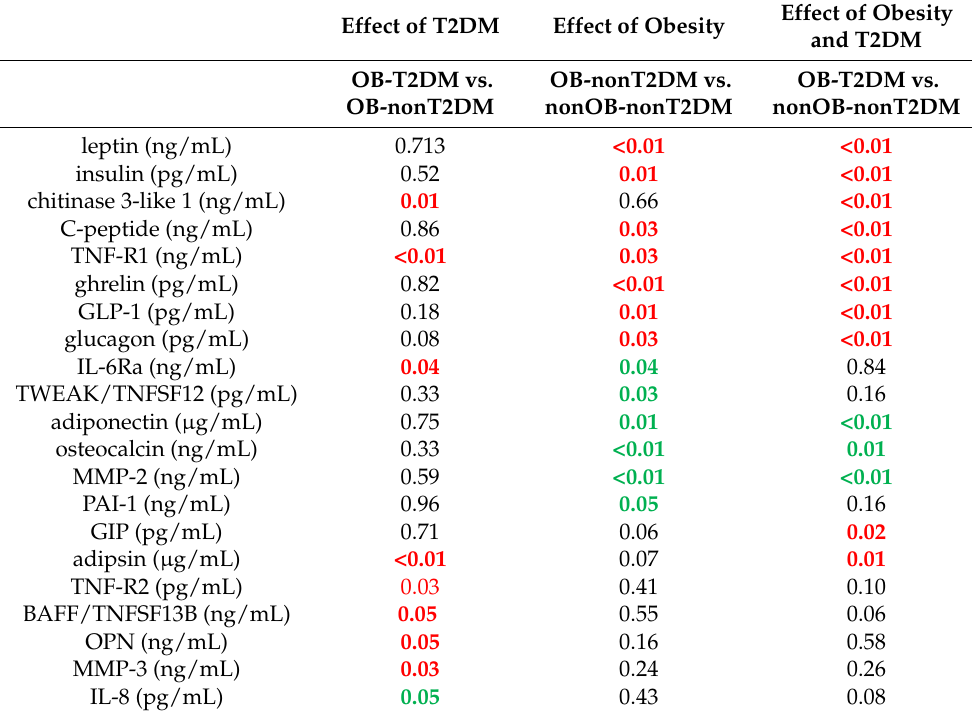
Table 1. Differential serum-circulating protein concentration due to obesity and T2DM.